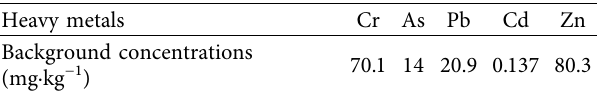
Table 2: The background concentrations of heavy metals in Qinghai